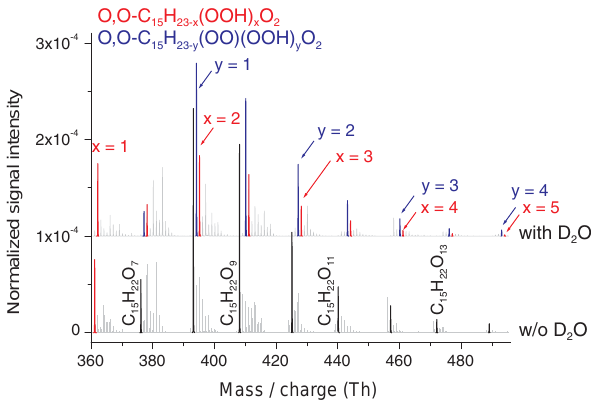
Figure 3. Ozonolysis of β -caryophyllene in the absence (lower part) and presence (upper part) of D 2 O applying nitrate ionization in the analysis. Signals highlighted in black stand for the sum of sig- nals in the absence of D 2 O from highly oxidized RO 2 radicals of the product groups simple AutOx., O,O–C 15 H 23 − x (OOH) x O 2 with x = 2 and 3, and ext. AutOx., O,O–C 15 H 23 − y (OO)(OOH) y O 2 , with y = 1 and 2, and the corresponding closed-shell product C 15 H 22 O 9 of the RO 2 radicals for x = 3 or y = 2. The addition of D 2 O leads to an H/D exchange of all acidic H atoms present in the molecule. Accordingly, signals from the two product groups are separated by the number of acidic H atoms and the split-up signals are highlighted in red for the simple AutOx. group and in blue for the ext. AutOx. group. [ β -caryophyllene] = 8 . 3 × 10 10 , [O 3 ] = 1 . 02 × 10 12 moleculescm − 3 , reaction time is 7.9s.